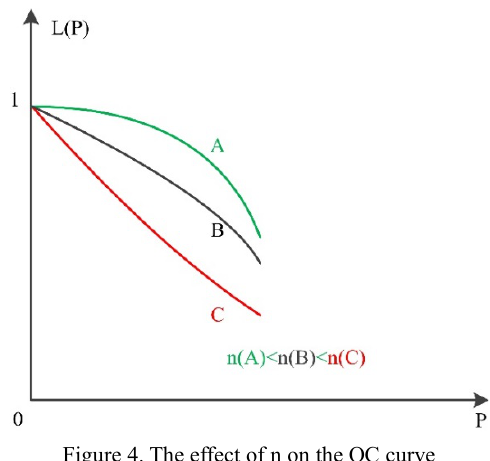
Figure 4. The effect of n on the OC curve